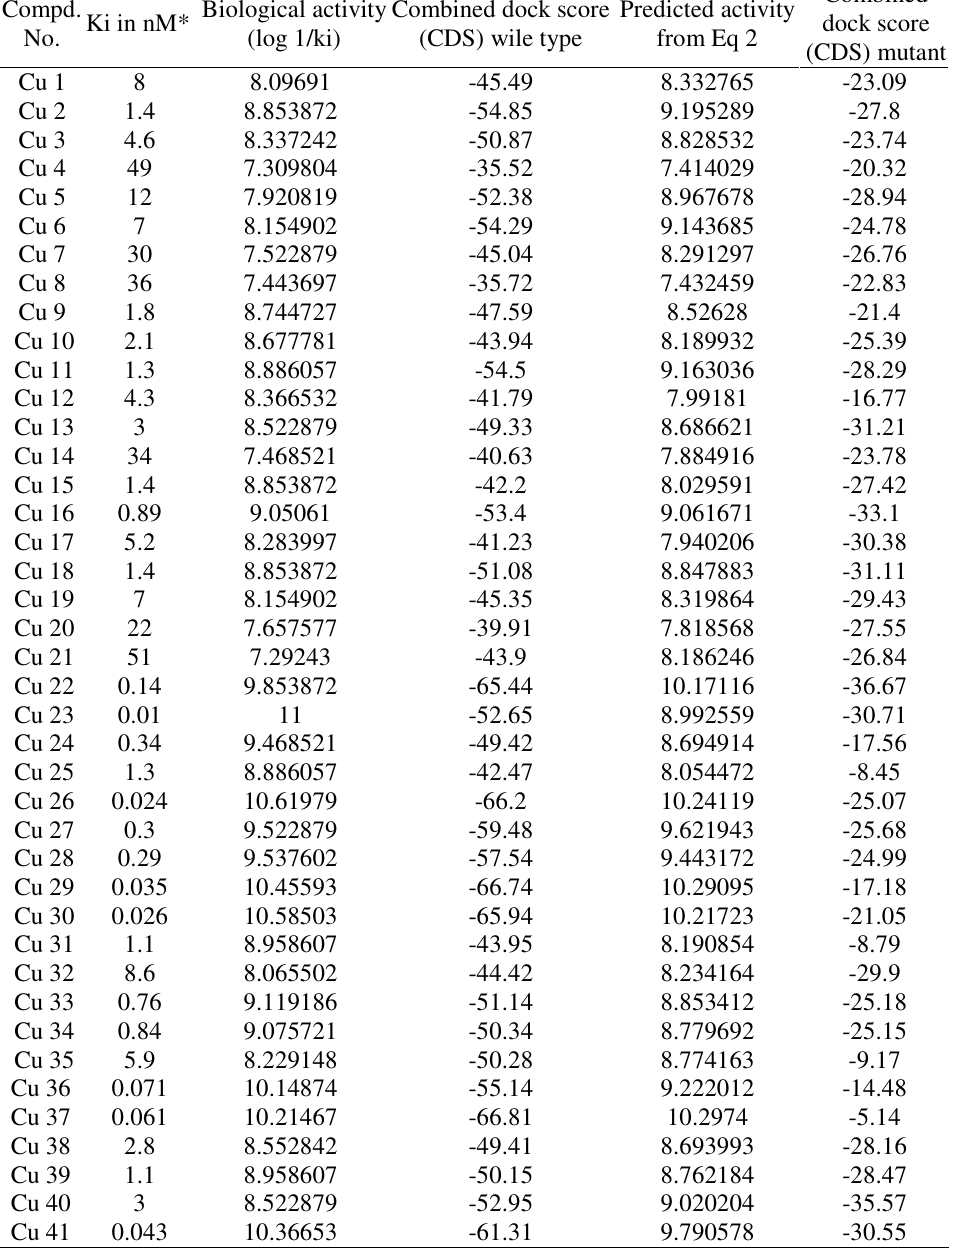
Table 2. Biological activity, combined dock score and predicted activity of known cyclic urea